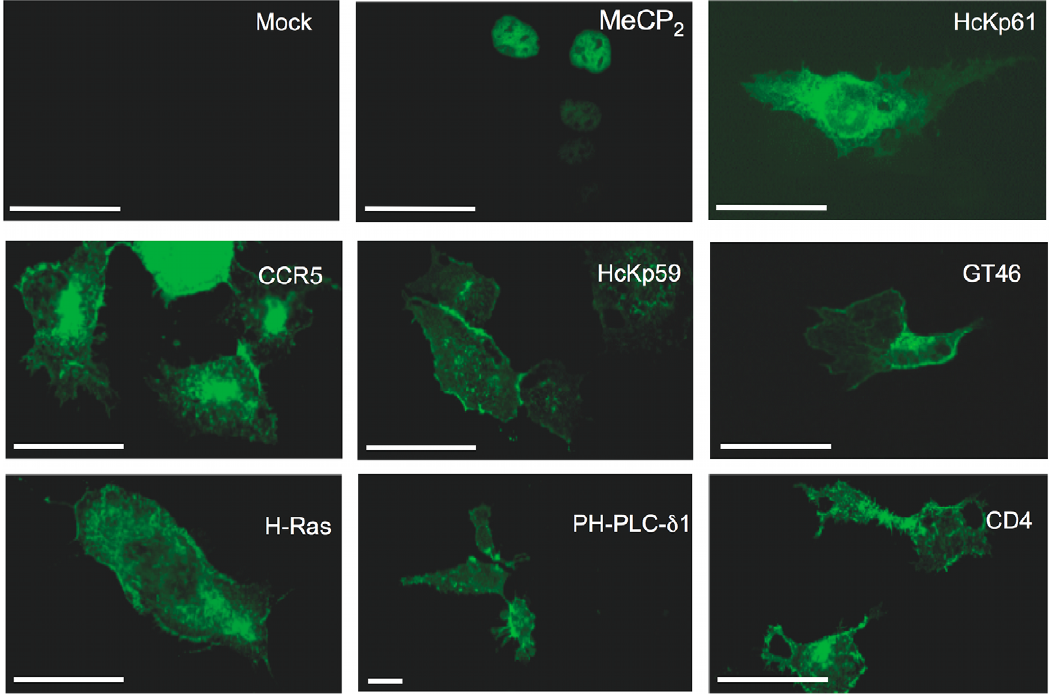
Figure 2. Localisation of GFP-tagged proteins overexpressed in HEK-Fc c RII cells. HEK-Fc c RII cells transiently transfected 48 hours earlier with constructs encoding the indicated GFP-tagged proteins were imaged by fluorescence microscopy. Although only nine transfectants are shown here for reasons of space, the localisation of each one of the proteins tested in this study was analyzed and found to conform to the localisation reported in the literature (see Table 1 and 2). Scale bars represent 50 m